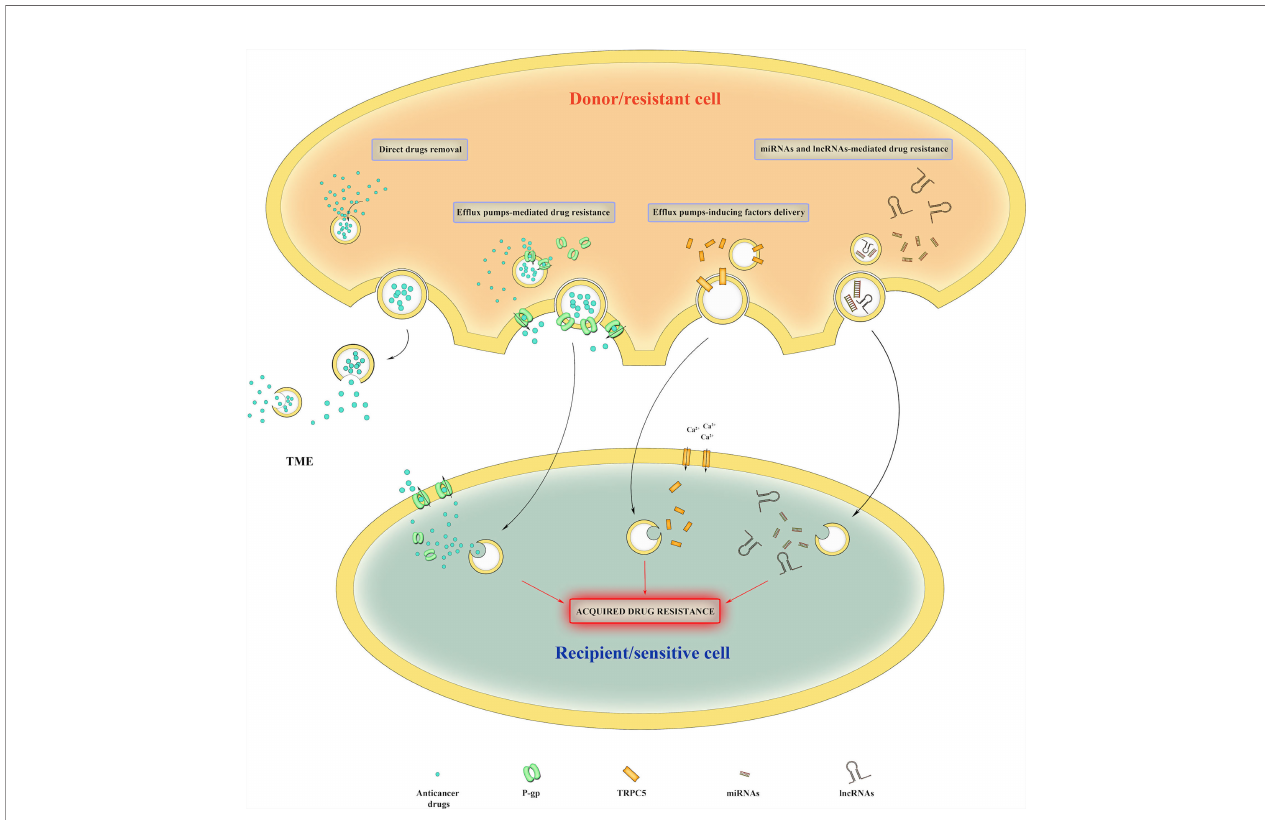
FIGURE 3 | Mechanisms of EV-mediated drug resistance. EVs can directly remove intracellular drugs from cancer cells. They can also deliver ef fl ux pumps, ef fl ux pumps-inducing proteins, miRNAs and lncRNAs to recipient cells, thus conferring them drug resistance